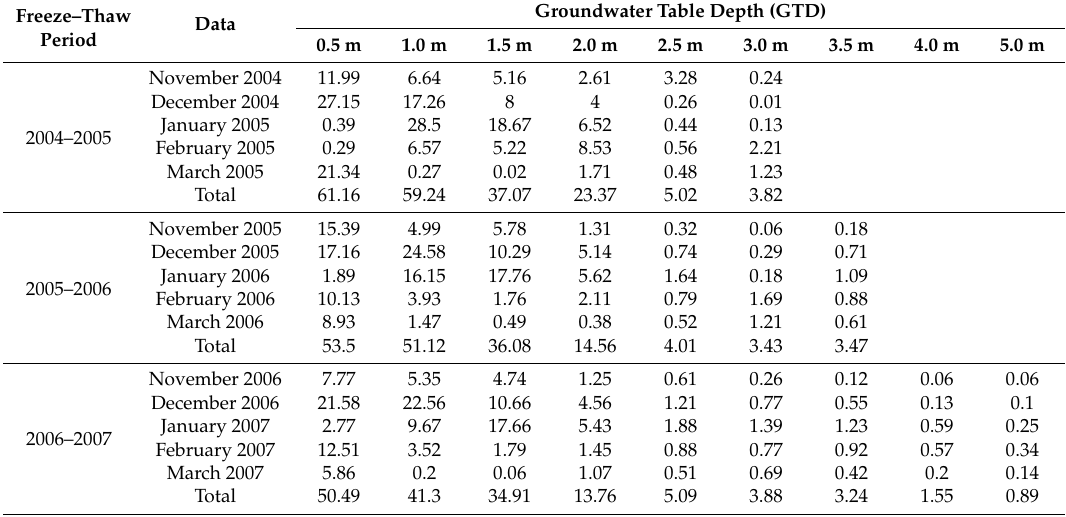
Table 5. Phreatic evaporation of fine sand during freeze–thaw periods. Unit: Millimeters. Freeze–Thaw Period